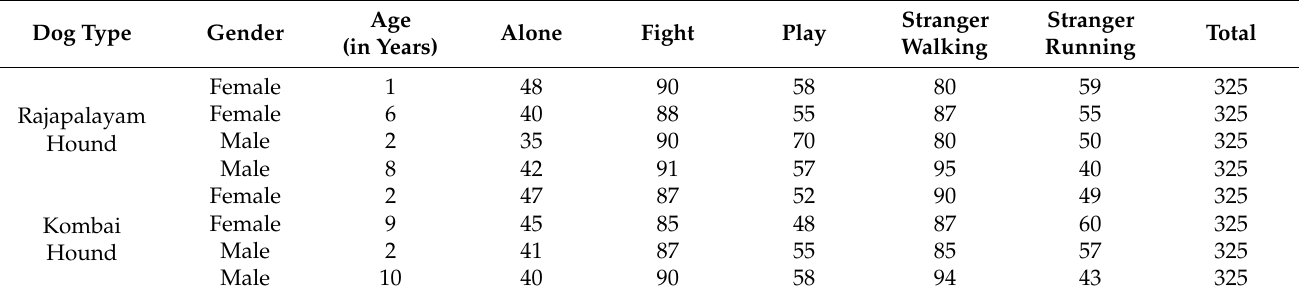
Table 1. Dataset of dog sounds with different